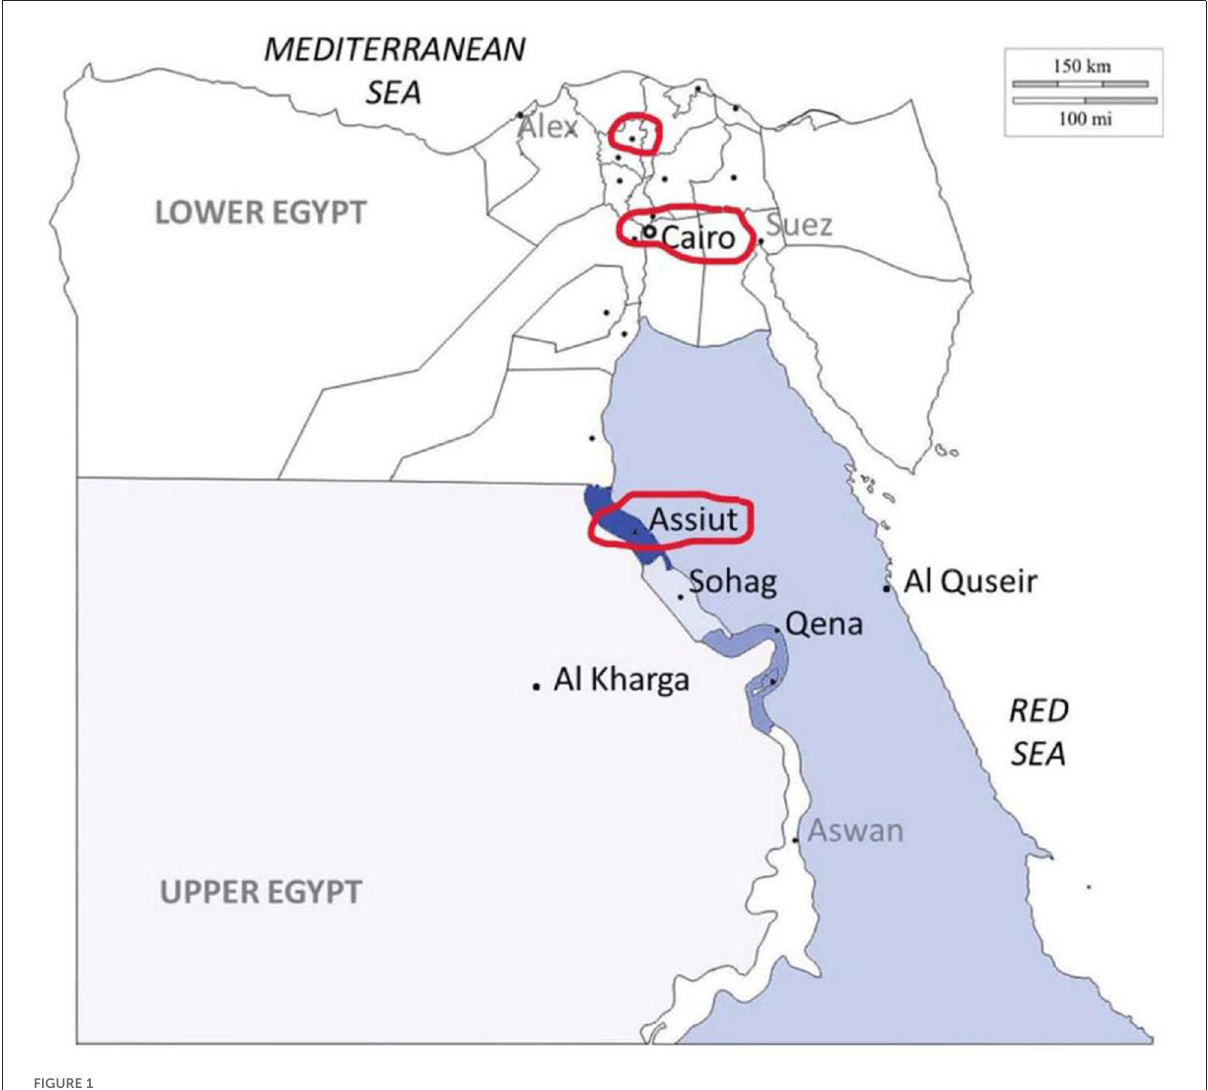
FIGURE1 Egypt map showing the distribution of catchment areas.